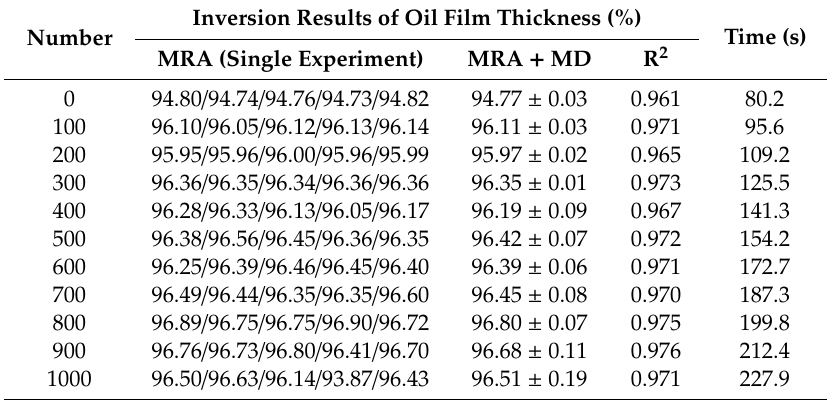
Table 6. Sample data self-expanding experiment inversion results.